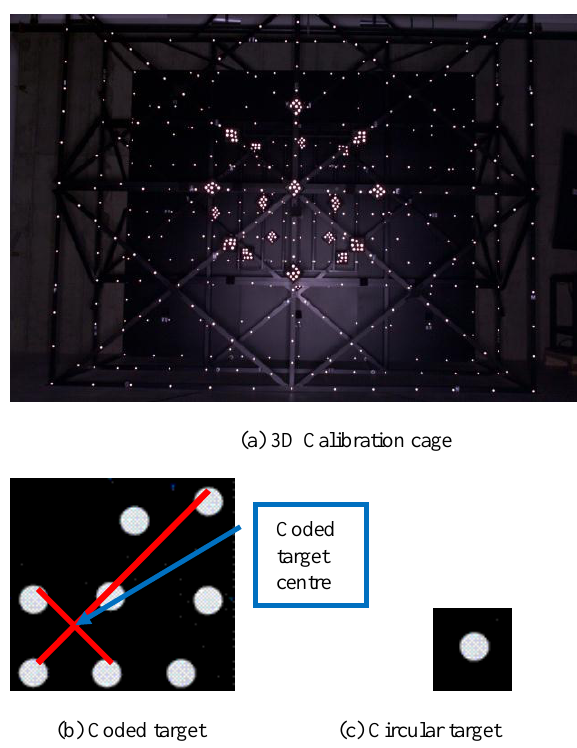
Figure 2. (a) Image of the calibration cage, with three panels (b) the pattern in a coded target and (c) the individual circular target The coded target centre is not the actual centroid of the individual target dots, but determined in a manner shown in Fig. 2(b). The software requires at least four coded targets in